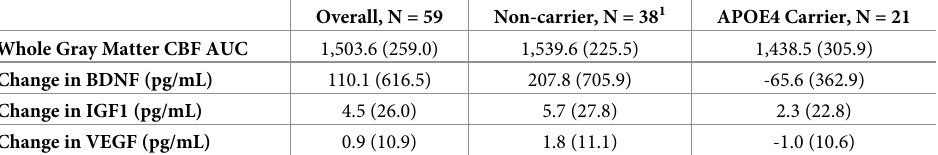
Table 2. Pre-specified primary and secondary outcomes.